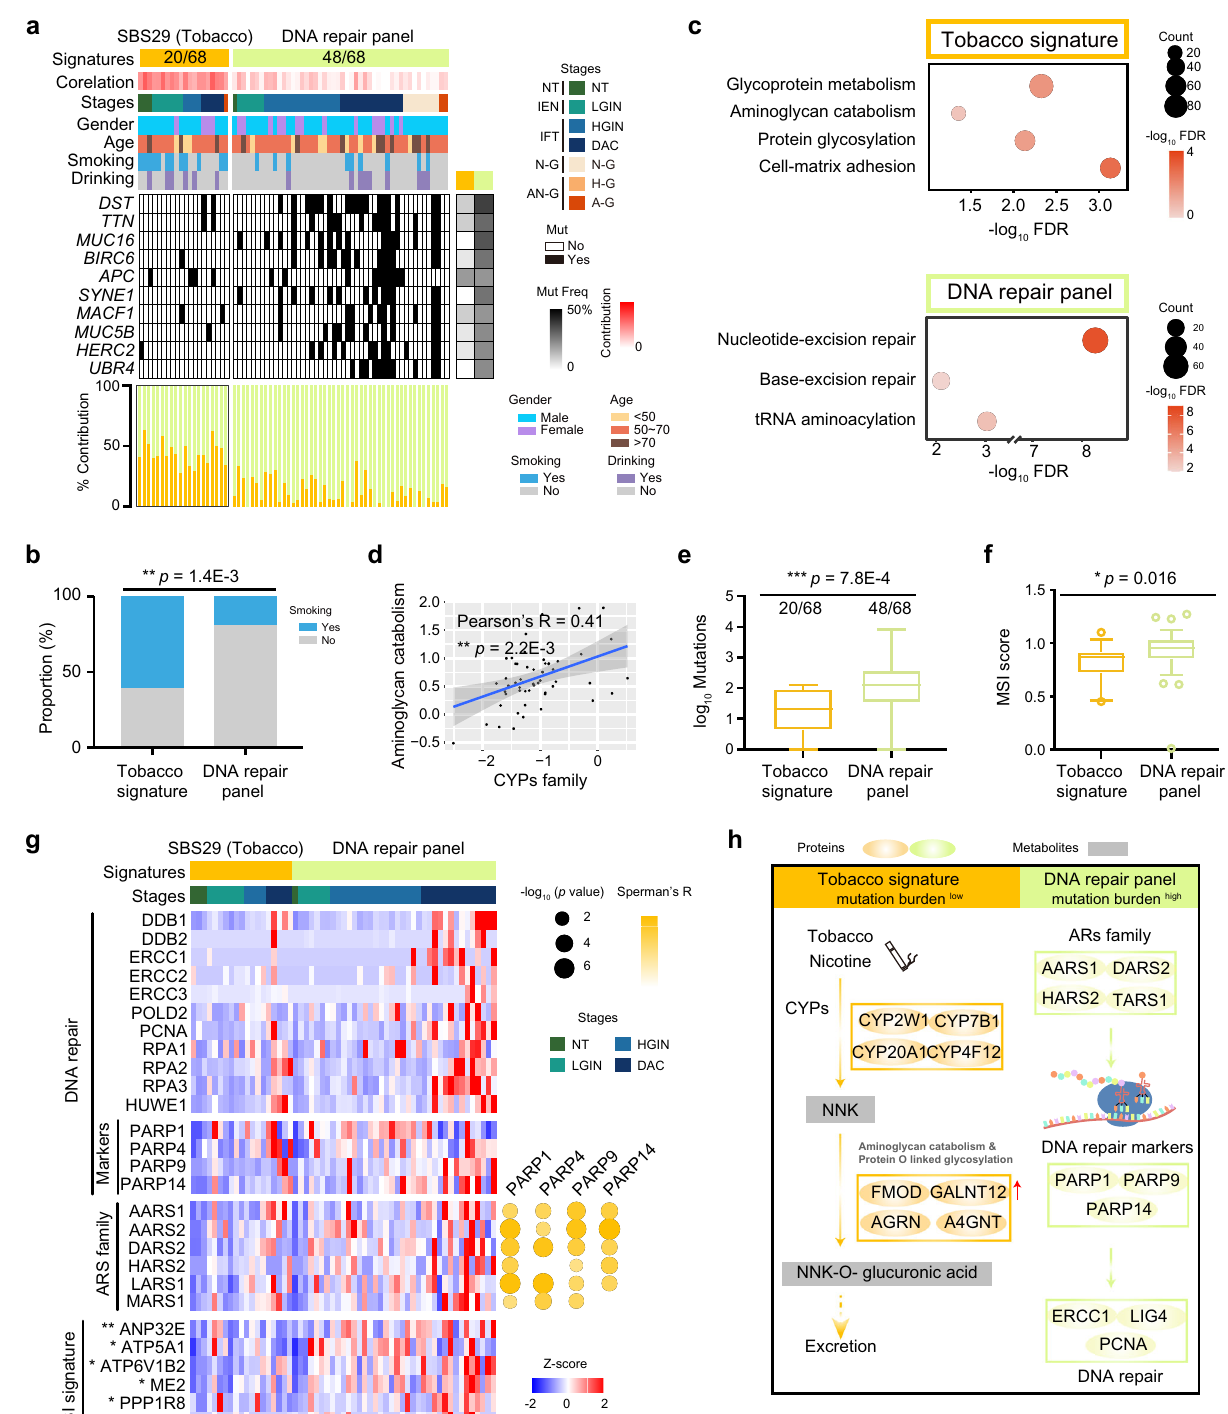
Fig. 2 | The impacts of the Tobacco signature and DNA repair panel in DC. a Heatmap showing the clinic information (top), correlated mutations (middle), andtheSBS29(Tobacco)signaturecontribution(bottom)intheDandGsubtypes. Thesquareisdirectedtoasubsetofpatientsamplesof theDandGsubtypesused for WES ( n =120). b Histogram showing the proportion of the samples with the habit of smoking in the Tobacco signature and DNA repair panel (two-sided Fish- er ’ s exact test). c The dominant pathways in the Tobaccosignature(top) and DNA repair panel (bottom). d Scatterplot showing the relationship between CYPs and aminoglycancatabolismatthe proteinlevel(two-sidedPearson ’ scorrelationtest). CYPs cytochromes P450 families. e Boxplot showing the TMB in the Tobacco signature and DNA repair panel (two-sided Wilcoxon signed-ranked test). Boxplot